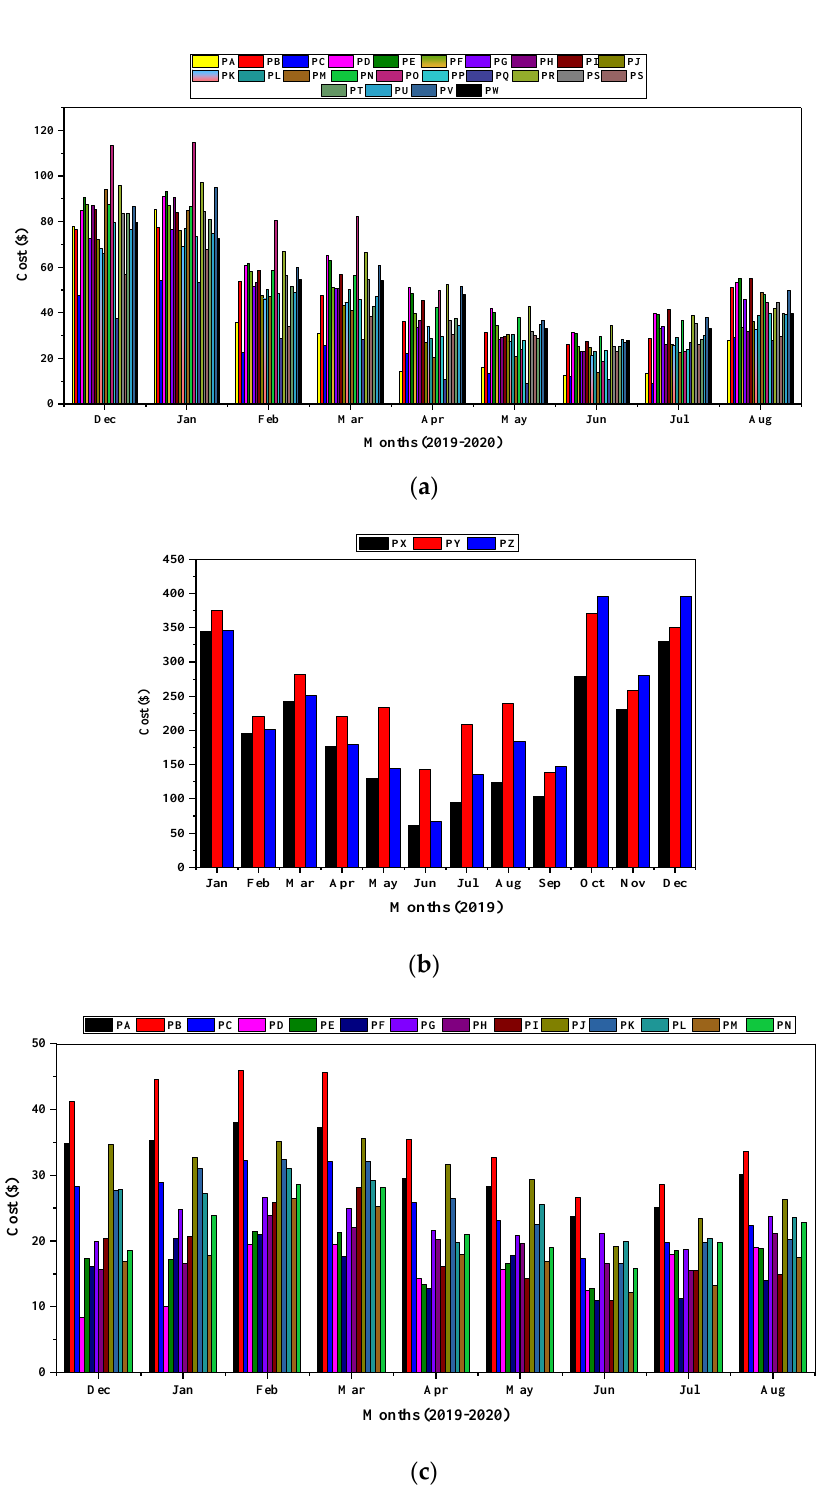
Figure A1. Monthly associated costs from excess energy retrieved by individual. Apartment units at ( a ) Evermore, ( b ) Gen Y, and ( c ) SHAC.